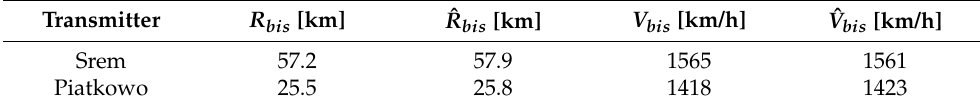
Table 1. Bistatic range and velocity measured for SWR160 plane.